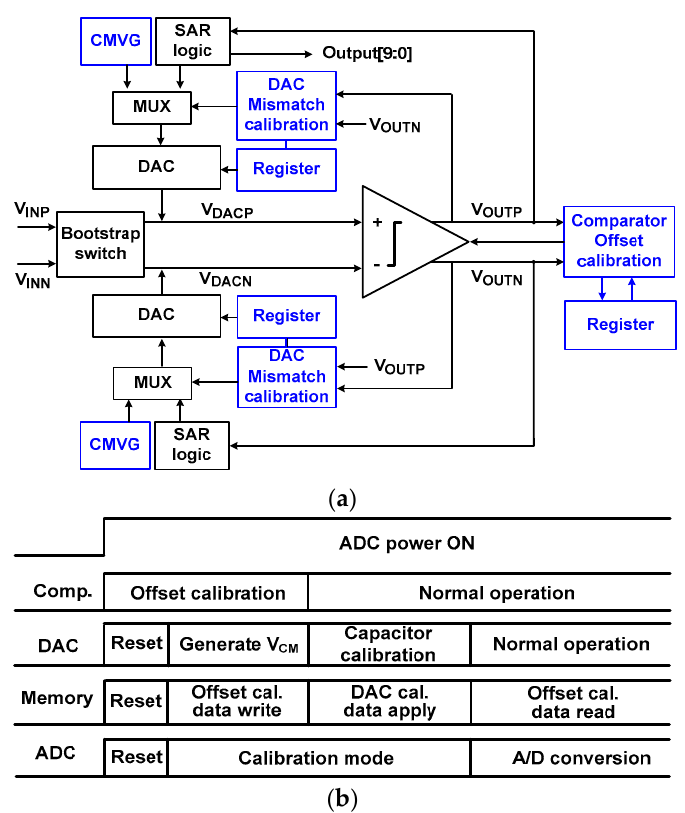
Figure 1. ( a ) Block diagram of the proposed analog-to-digital converter (ADC) with dual calibration. ( b ) Timing sequence of the ADC.